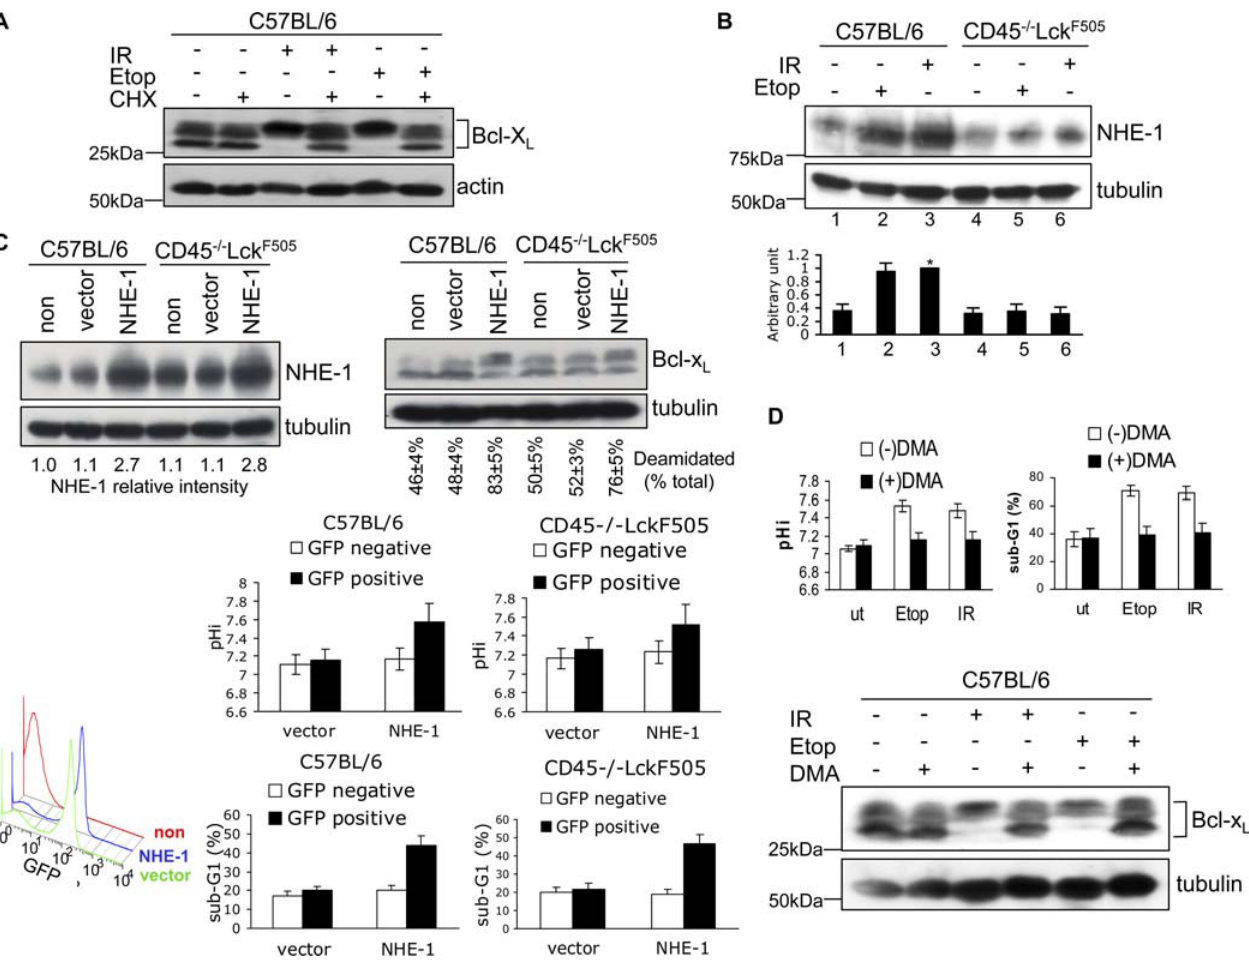
Figure 4. Bcl-x L Deamidation Induced by DNA Damage Involves Up-Regulation of the NHE-1 Na/H Antiport (A) Bcl-x L deamidation induced by DNA damage requires de novo protein synthesis. Wild-type thymocytes were either treated with etoposide for 24 h (Etop), or exposed to 5 Gy of irradiation (IR) and then maintained in culture for 24 h, with or without 0.5 l M cycloheximide (CHX). Cell lysates were processed by immunoblotting for Bcl-x L or b -actin (loading control). (B) DNA damage causes up-regulation of NHE-1 in wild-type but not in CD45 (cid:1) / (cid:1) Lck F505 thymocytes. Wild-type or CD45 (cid:1) / (cid:1) Lck F505 thymocytes were either treated with etoposide (Etop) for 5 h, or exposed to 5 Gy of irradiation (IR) and then maintained in culture for 5 h before immunoblotting for NHE-1 or tubulin (loading control). The histogram shows the quantification of relative NHE-1 expression levels SD from five independent experiments. Lane 3 was defined as 1 (*). (C) Migri-NHE-1 or empty Migri vector were transduced into wild-type or pretumourigenic CD45 (cid:1) / (cid:1) Lck F505 thymocytes. 72 h after the first round of infection, cells were immunoblotted for NHE-1 and Bcl-x L . NHE-1 expression levels (NHE-1 relative intensity) were normalised for loading using tubulin values. Deamidation was calculated as in Figure 1B. The lower left FACS histogram shows the infection efficiency for nontransfected (non), empty-vector transfected (vector), or NHE-1 transfected (NHE-1) cells as percentage GFP-positive cells. The lower right histograms show the mean pH i and apoptosis (sub-G1) values 6 SD ( n ¼ 5) analysed on GFP-negative and positive cells. (D) The NHE-1 inhibitor DMA blocks DNA damage-induced alkalinisation (top left panel), Bcl-x L deamidation (lower panel) and apoptosis (top right panel) in wild-type thymocytes. Thymocytes were treated with Etoposide for 24 h, or exposed to 5 Gy of irradiation and then maintained in culture for 24 h, with or without 200 l M DMA. pH i was measured by FACS on live CD4 (cid:1) CD8 (cid:1) cells, and the sub-G1 peak was analysed by FACS on CD4 (cid:1) CD8 (cid:1) cells to assess apoptosis. The histograms represent mean values 6 SD ( n ¼ 3).